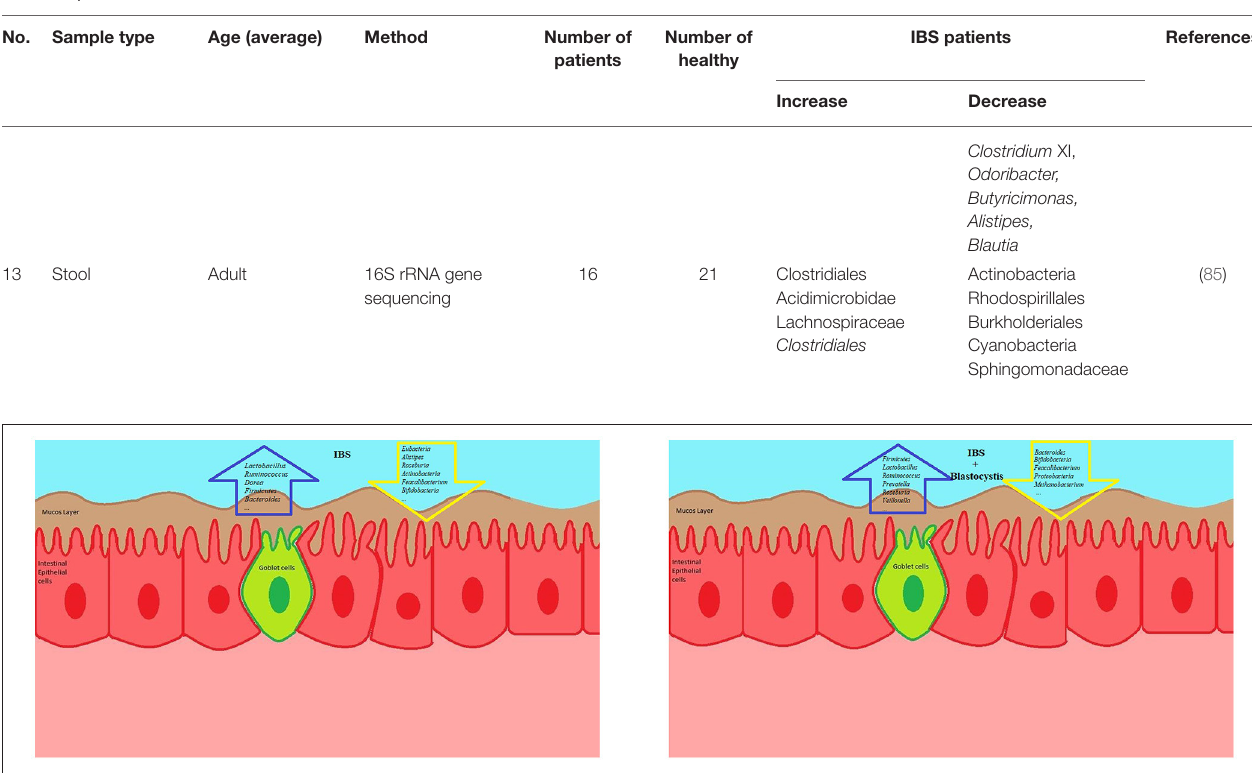
Oscillibacter , whereas Proteobacteria and the genera Escherichia